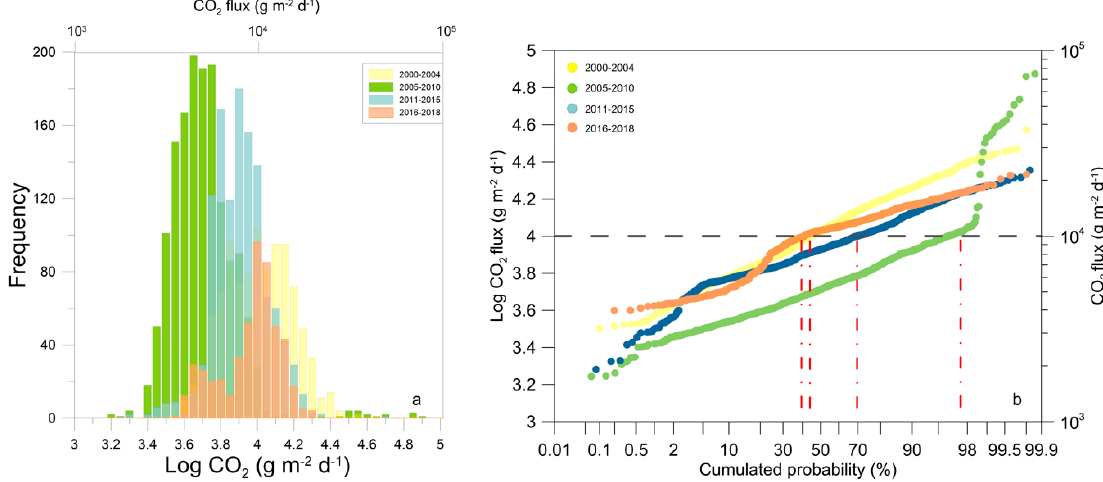
Figure 3. ( a ) Frequency histogram of log CO 2 flux of the four sub-periods (2000–2004, 2005–2010, 2011–2015, 2016–2018); the data shows a quasi-unimodal distribution for the first three periods and bimodal for the last period; ( b ) cumulative probability diagram of log CO 2 flux, the data distribution highlights the different percentage of values over 10,000 g · m − 2 · d − 1 . The 2016–2018 sub-period is characterized by the highest percentage (more than 50%) of data over 10,000 g · m − 2 · d − 1 ) similar to the 2000–2004 period. The other two sub-periods (2002 and 2014) showed only 2% and 30%, above 10,000 g · m − 2 · d − 1 , respectively.